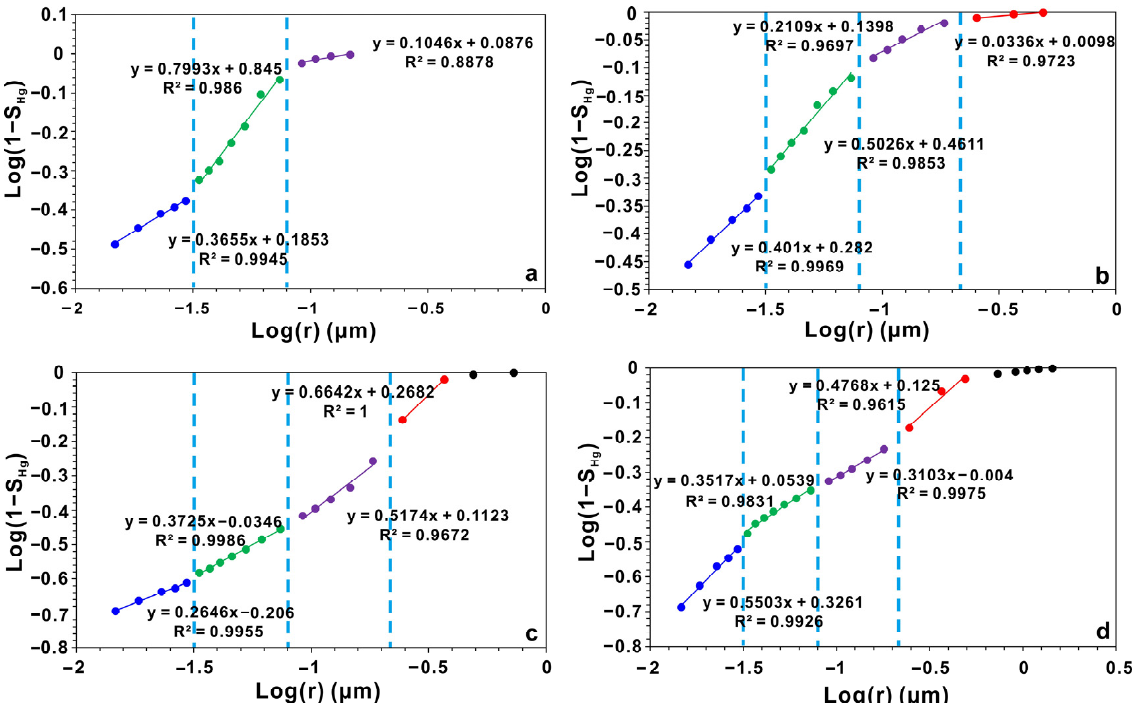
Figure 4. Fractal characteristics of pore throats in Chang 7 1-2 sub-member shale oil reservoirs. ( a ) Porosity (6.4%) and permeability (0.043mD), ( b ) Porosity (7.6%) and permeability (0.056mD), ( c ) Porosity (12.4%) and permeability (0.151mD) and ( d ) Porosity (9.8%) and permeability (0.523mD).